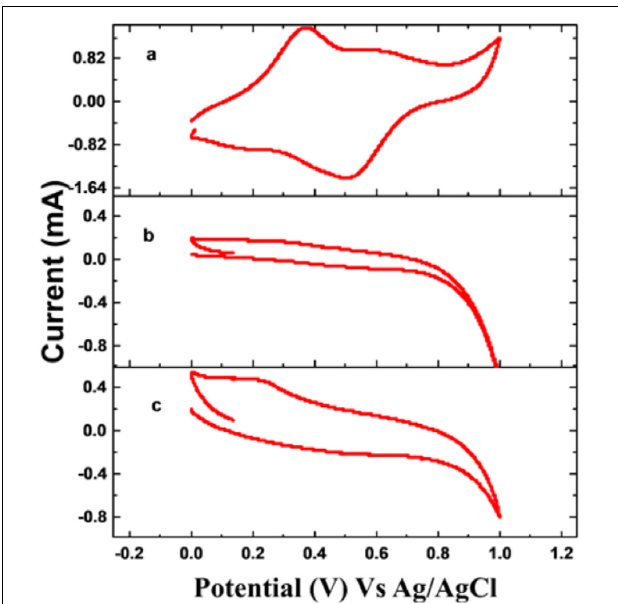
(EDC) was acquired from Sigma Aldrich (Germany). The